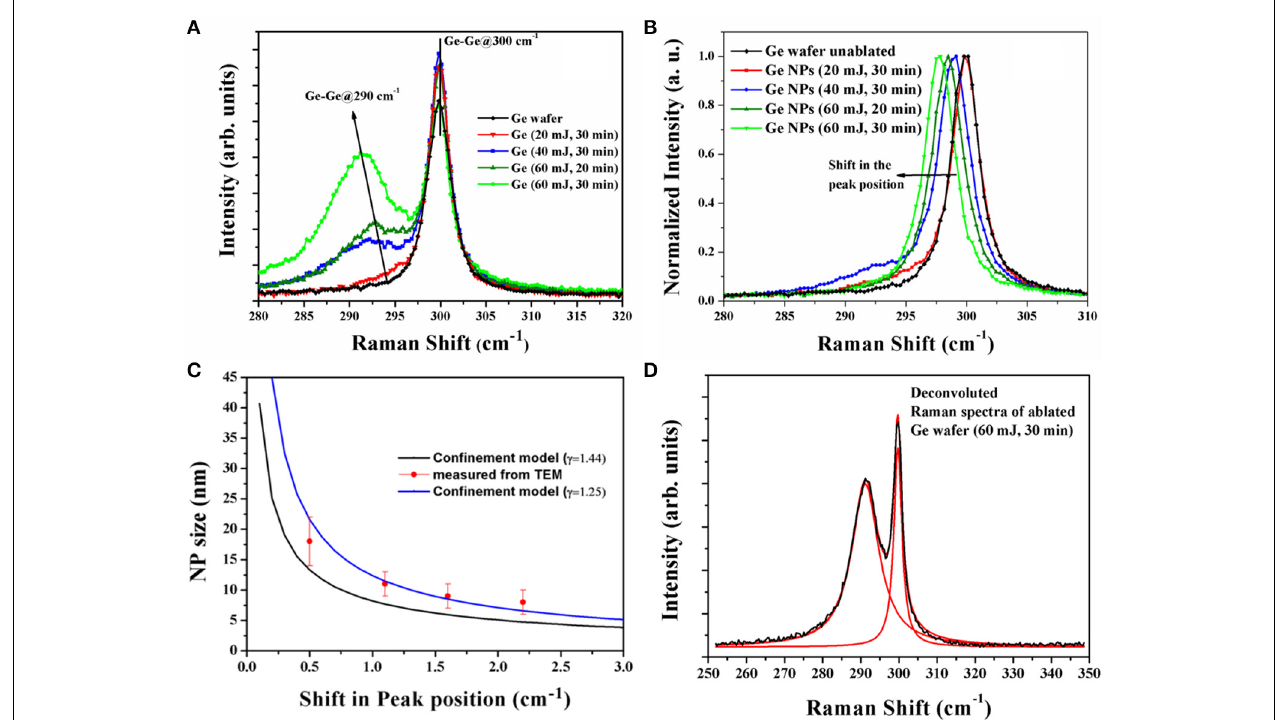
FIGURE 2 | Micro Raman spectra of (A) laser ablated Ge wafer at different laser pulse energies, (B) different energy synthesized Ge NPs in acetone drop casted on glass slide, (C) variation of NP size with shift in the Raman